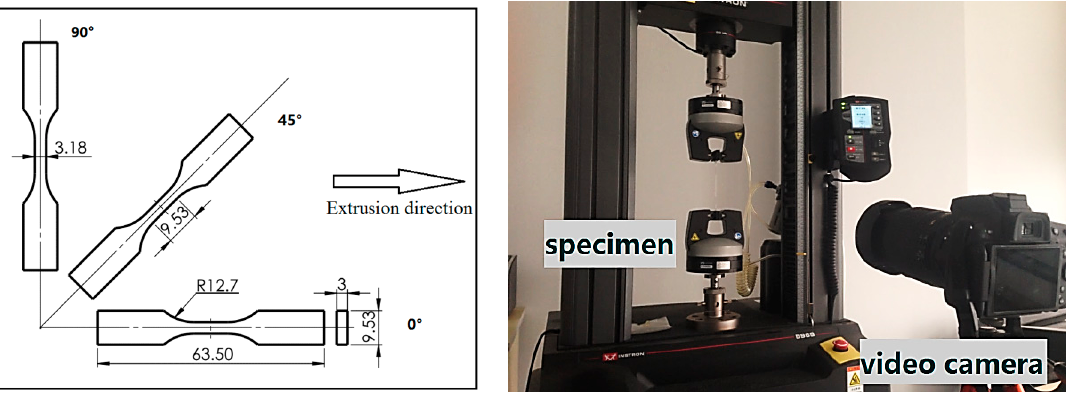
Figure 2. Geometry of tension specimen and the tensile test set-up with video camera.